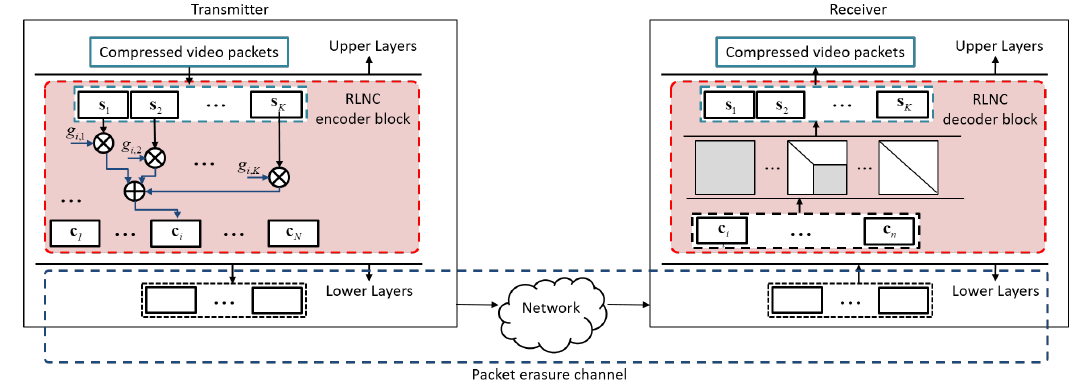
Figure 1. Generic RLNC sub-layers at the transmitter and the receiver side connected via packet erasure